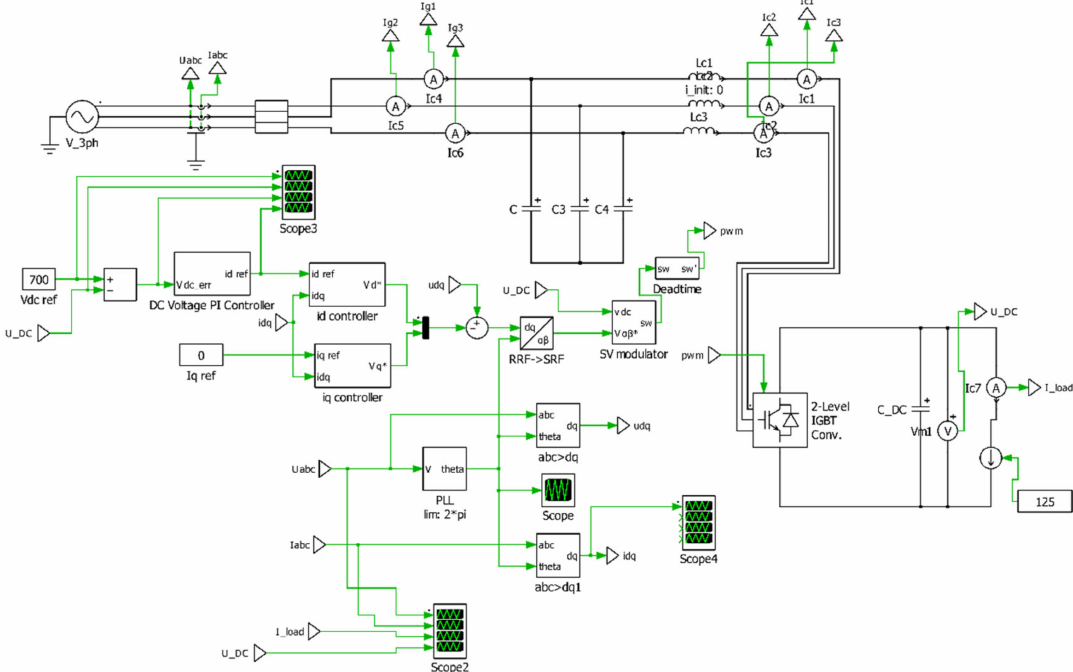
Figure 5. Simulation model of 2-level AC/DC converter module with VOC control developed in PLECS